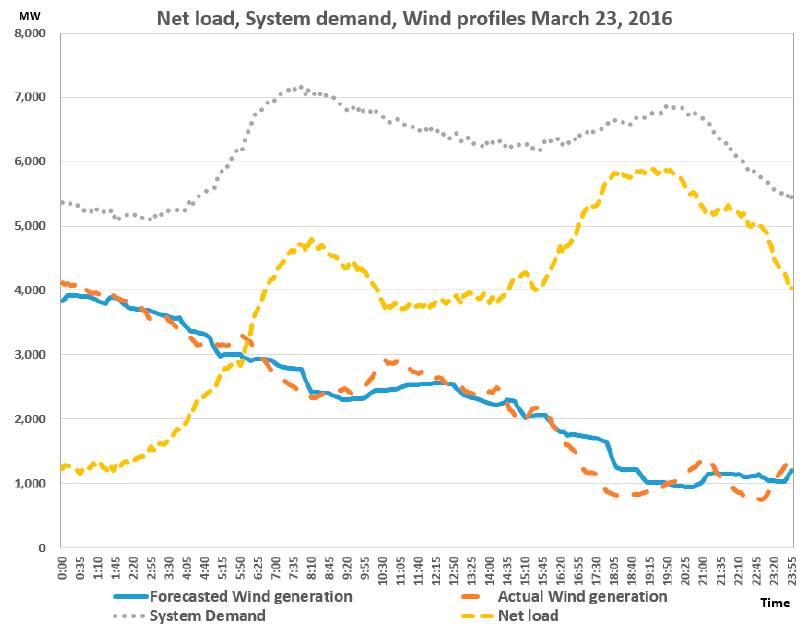
Figure 1. Load and wind generation profiles during one day in March 2016 [2].